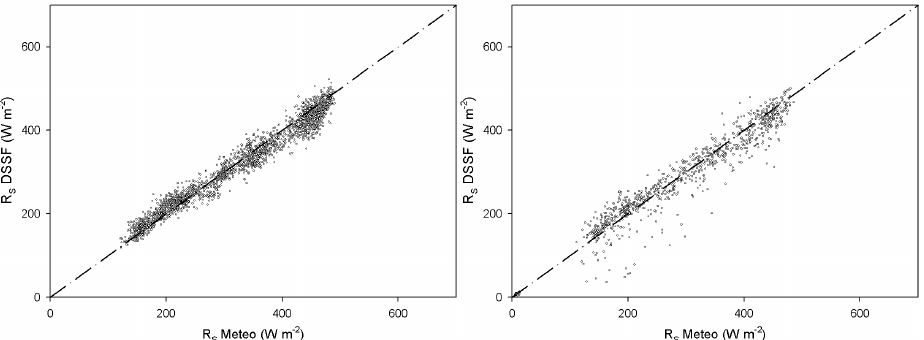
Fig. 4. Monthly DSSF solar radiation ( R s DSSF) vs. monthly meteorological station solar radiation ( R s DSSF) from 2008 to 2010, segmented Figure 4. Monthly DSSF solar radiation (R into flat or hilly terrain classes. Solid line is the 1 : 1 solar radiation (R Solid line is the 1:1 ratio. 4